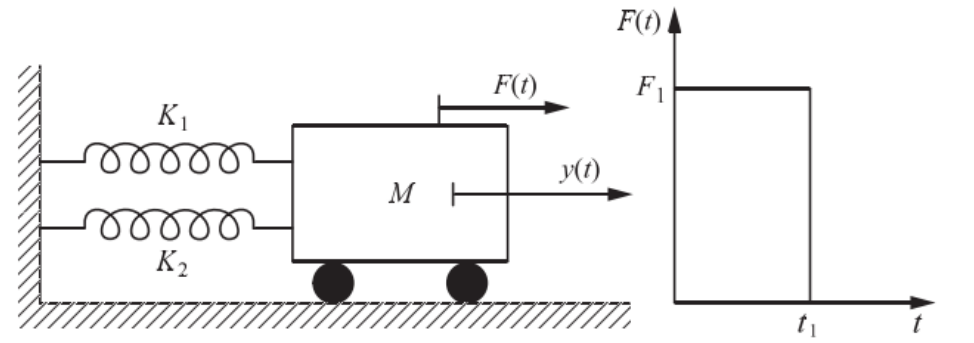
Figure 7. Illustration of the SDoF oscillator system. Table 3. Random variables of the SDoF oscillation system.